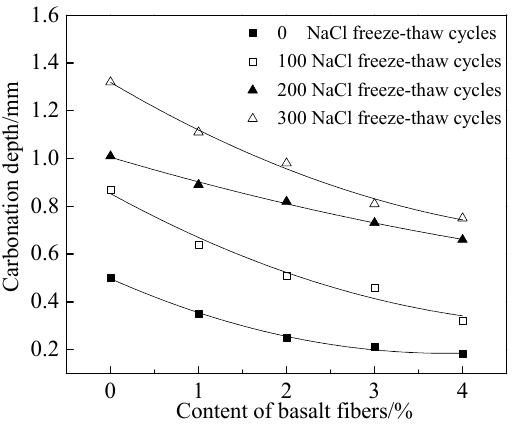
Figure 8. Carbonation depth of SAC-RPC during different NaCl freeze-thaw